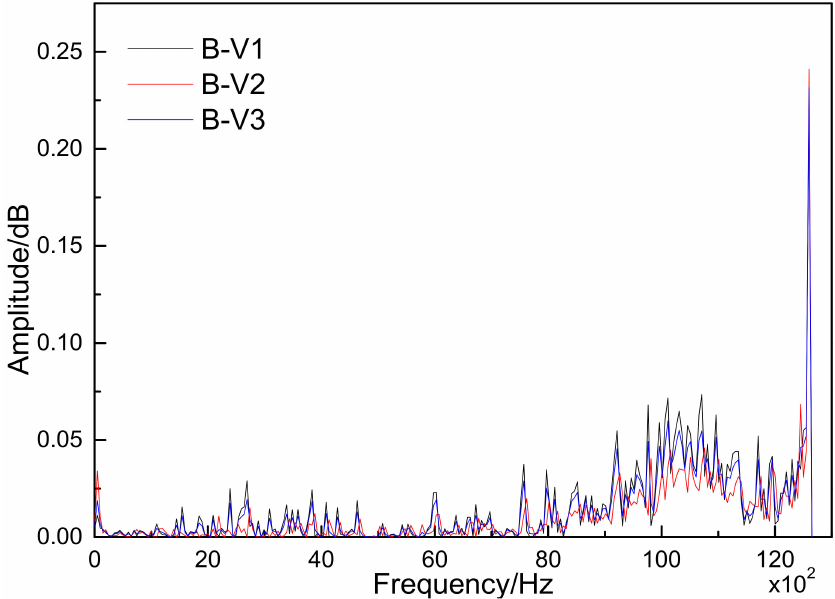
Figure 12. HHT marginal spectra of the AE signals for different